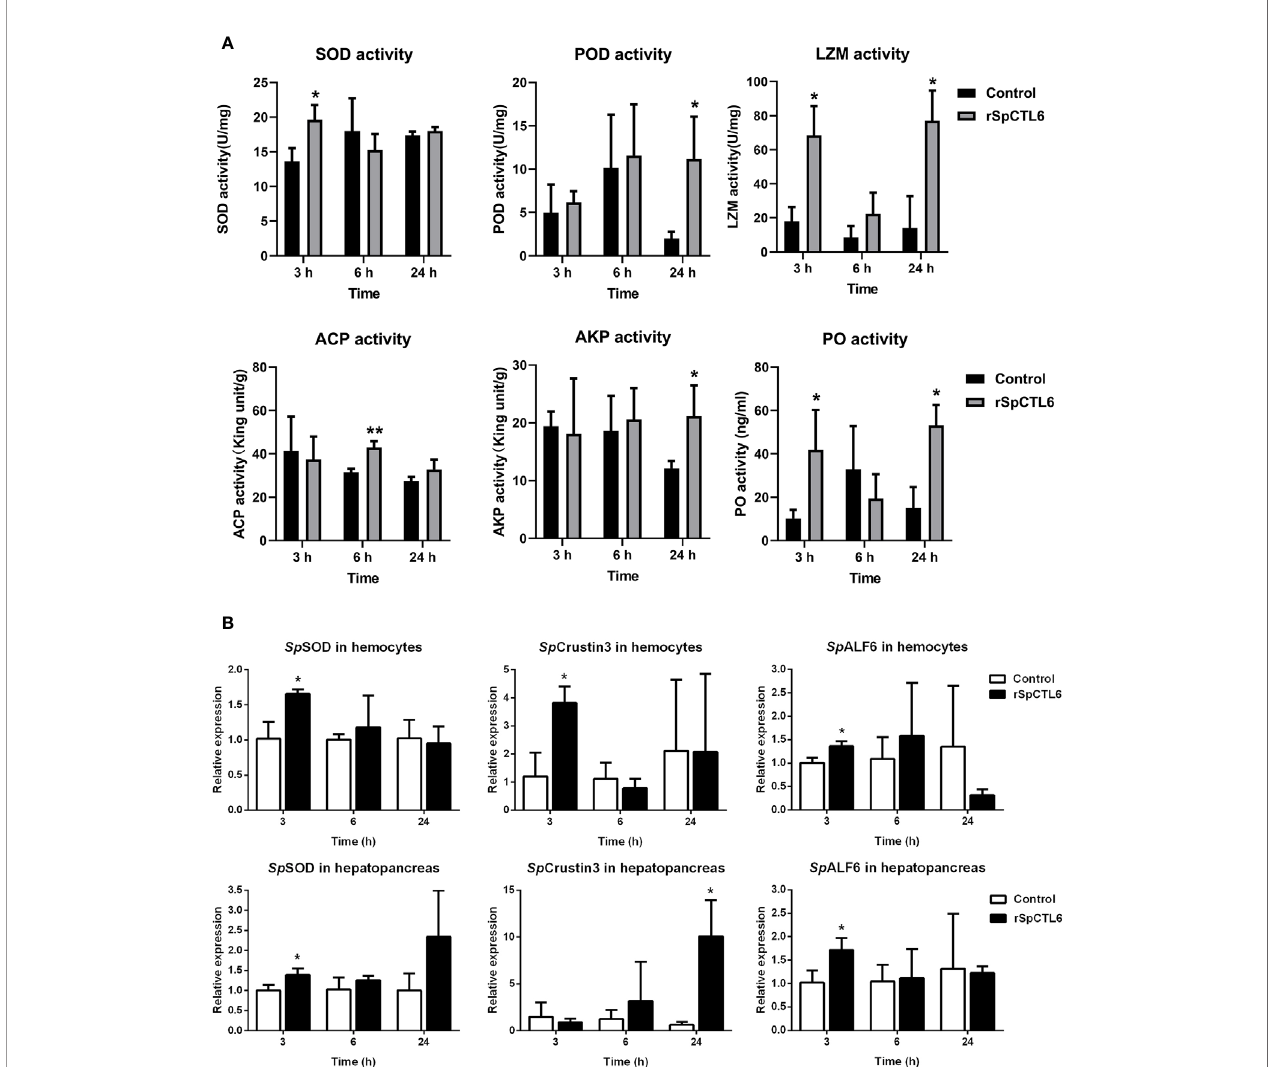
FIGURE 7 | The regulatory role of rSpCTL6 in S. paramamosain . Enzymatic activity analysis (SOD, POD, LZM, ACP, AKP, and PO) in hepatopancreas after rSpCTL6 treatment of S. paramamosain challenged with V. alginolyticus (n=3) (A) . The immune-related gene ( Sp SOD, Sp Crustin3 and Sp ALF6) expression in hemocytes and hepatopancreas were examined (n=3) (B) . Signi fi cant difference between rSpCTL6 treatment group and the crab saline injection group was indicated by asterisks as * p <